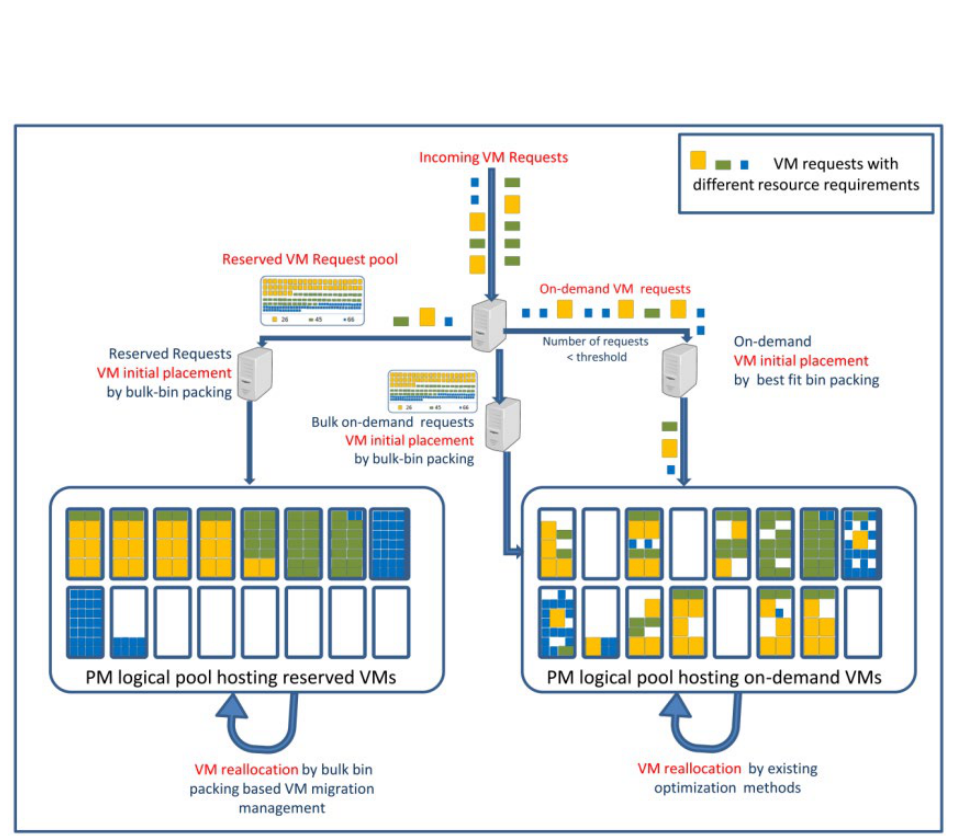
Figure 1. Logical View of a VM initial placement and migration manager